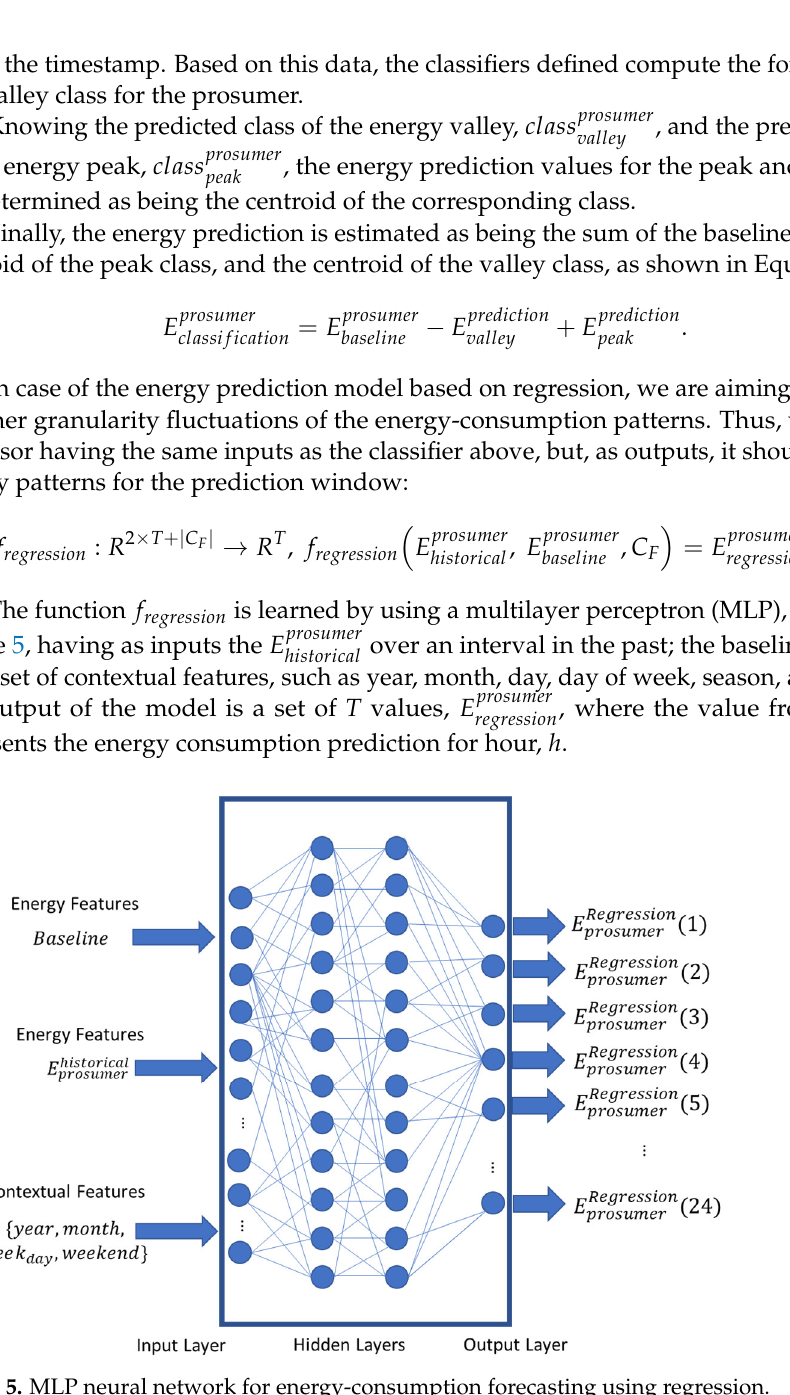
Figure 5. MLP neural network for energy-consumption forecasting using regression.